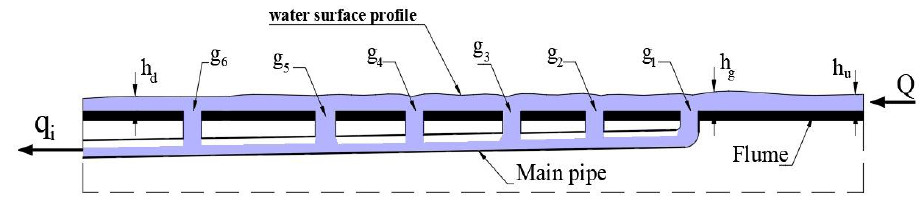
Figure 2. Longitudinal cross-section of flume and main pipe system.